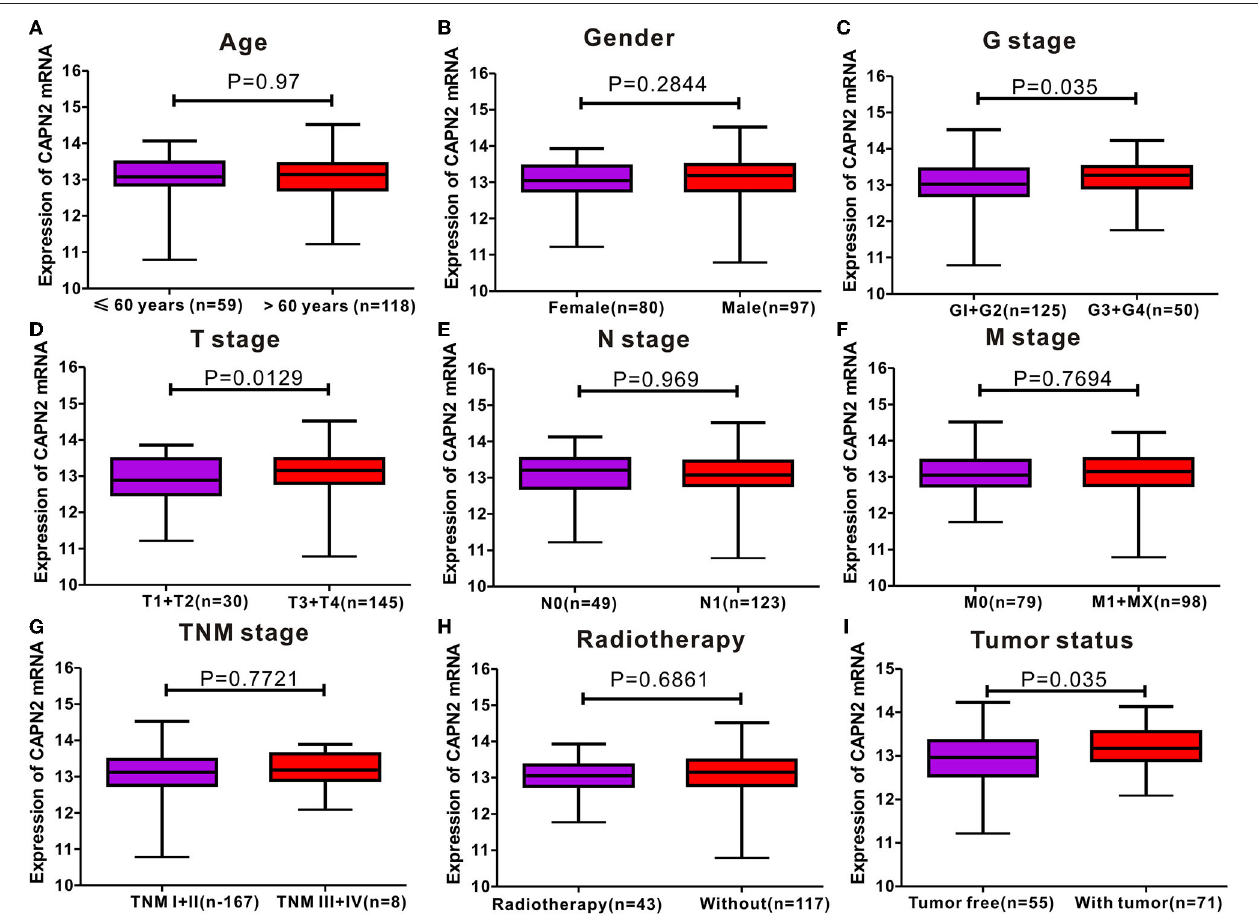
FIGURE 2 | Correlation analyses between CAPN2 mRNA levels and different clinicopathological characteristics of patients with PC. The association between CAPN2 levels and clinicopathological characteristics of patients with PC, including (A) age ( P = 0.97); (B) sex ( P = 0.2844); (C) tumor grade (G) stage ( P = 0.035); (D) tumor (T) stage ( P = 0.0129); (E) node N stage ( P = 0.969); (F) metastasis M stage ( P = 0.7694); (G) tumor node metastasis (TNM) stage ( P = 0.7721); (H) radiotherapy ( P = 0.6861); (I) tumor status ( P =